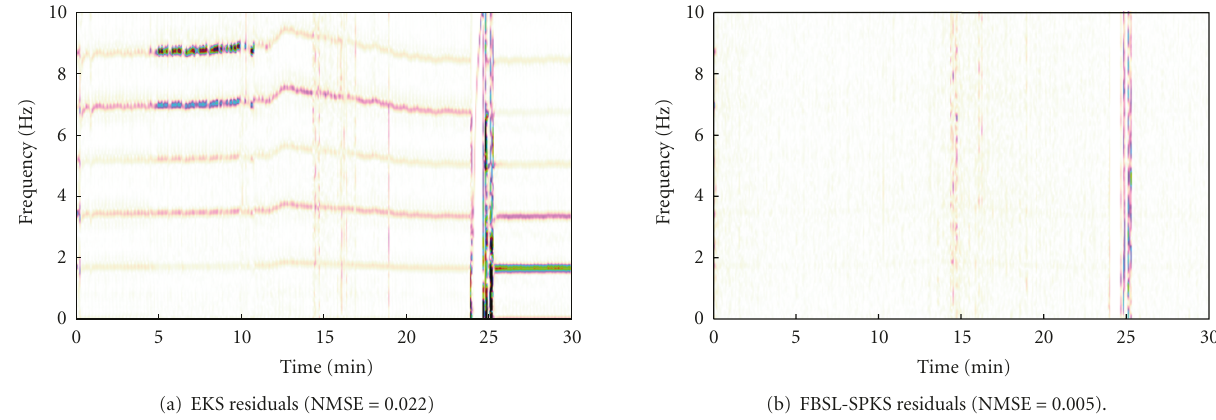
Figure 10: (a) Spectrogram of residuals of the EKS tracking of an ABP signal. (b) Spectrogram of residuals of the FBSL-SPKS tracking of an ABP